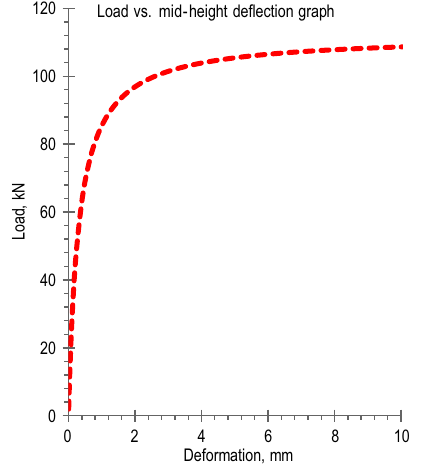
Fig.13. Load vs. mid-height deflection graph of test